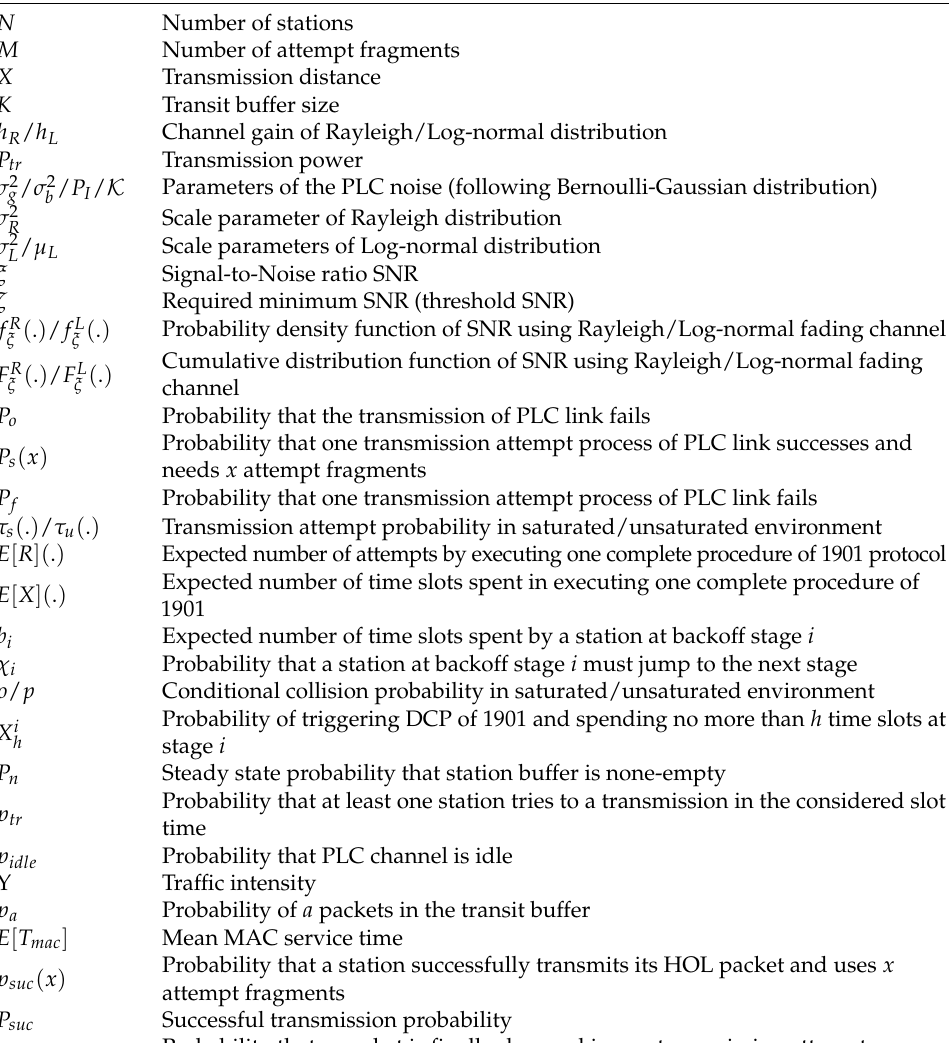
Table 3. Notation list relevant to essential results derived by the analytical